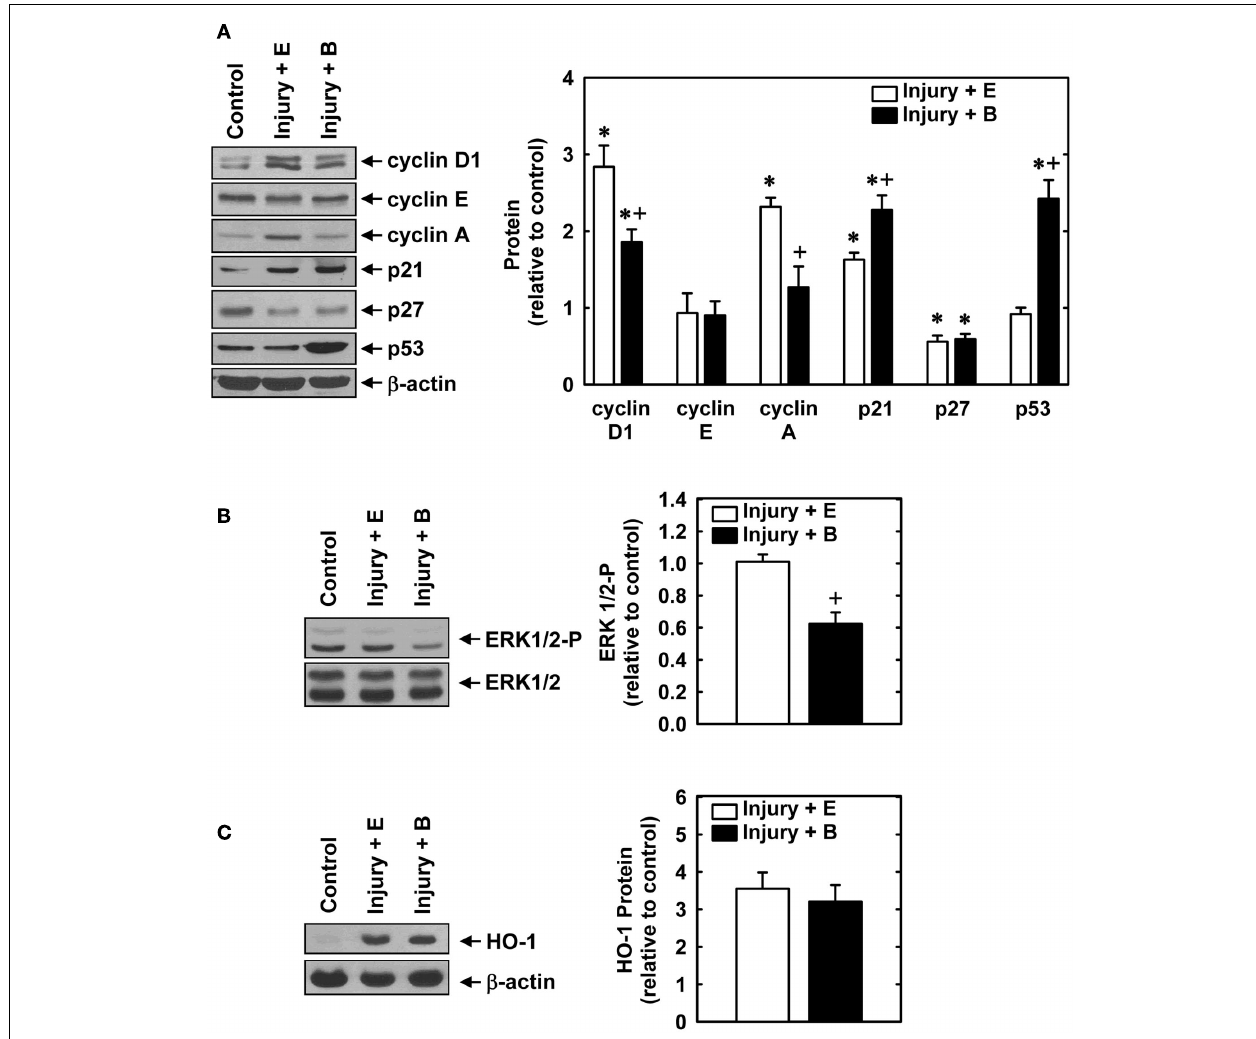
an empty (E) gel or a gel containing bilirubin (B) 2days after injury. (C) Expression of HO-1 in control and injured arteries treated with an empty (E) gel or a gel containing bilirubin (B) 2days after injury. Quantification of relative protein levels was achieved by scanning densitometry. Results are means ± SEM ( n = 3–5). *Statistically significant effect of arterial injury. + Statistically significant effect of